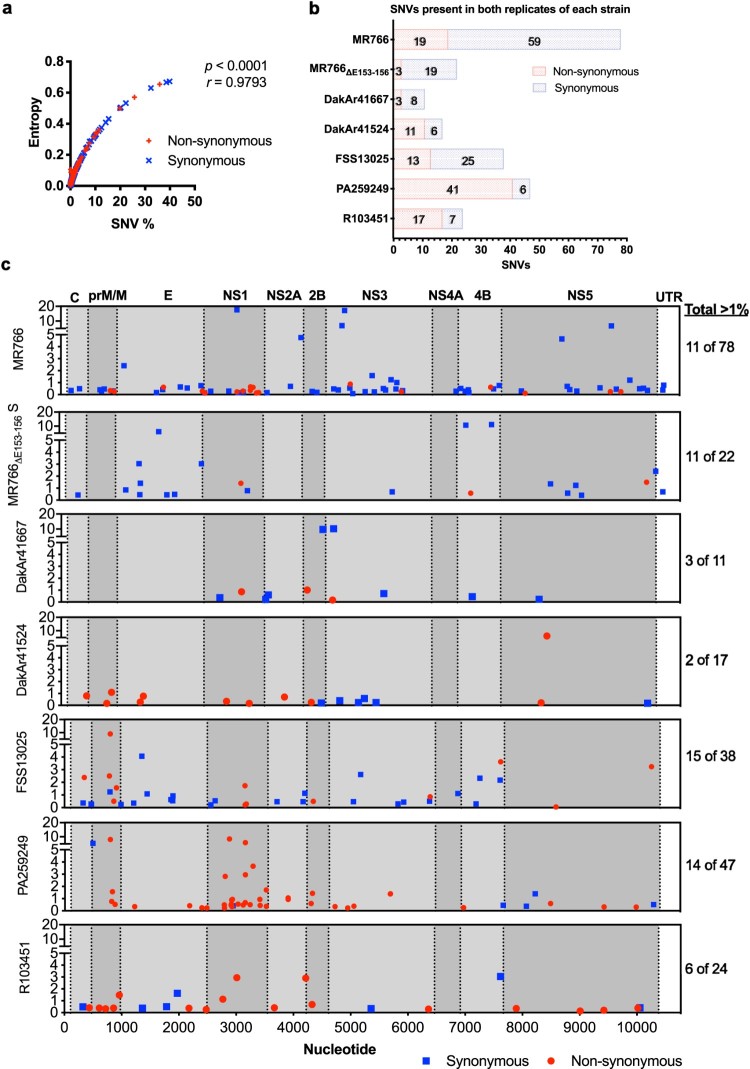
SNVs detected in all ZIKV strains. A) For all positions with SNVs, the frequency percentage and entropy values are correlated (Spearman correlation, r = 0.9793). B) The total number of SNVs identified and common to both replicates of each ZIKV are shown: synonymous change (blue bar), non-synonymous change (red bar). C) Mean frequency values of all SNVs common to both replicates were plotted by nucleotide position, synonymous (blue), non-synonymous (red). Genomic regions (UTRs and proteins) are denoted by dotted lines and alternating background shading under a genome map. The number of SNVs present at greater than 1% frequency out of the total number of SNVs is provided on the right.